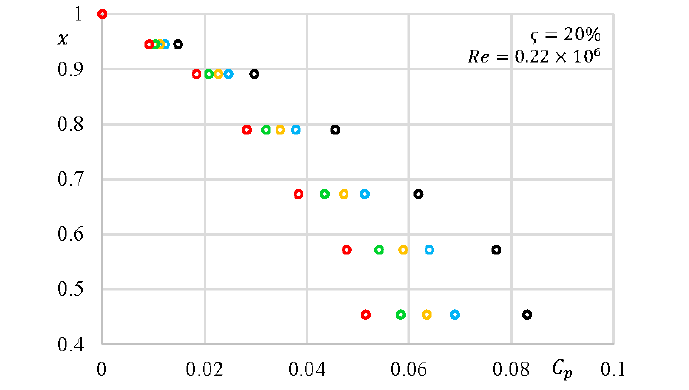
ς = 20% from measurements. p at